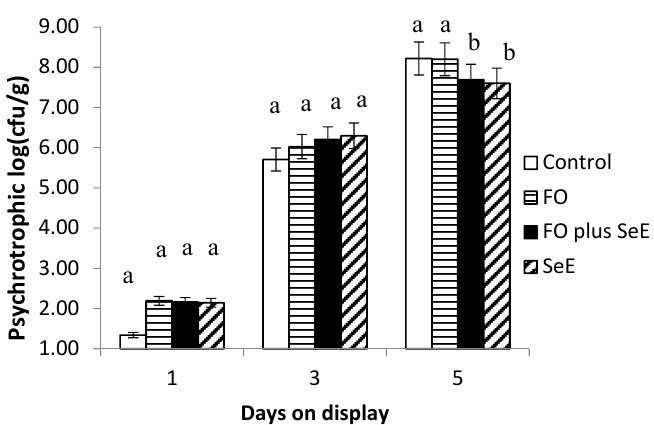
Figure 2. Mean log counts of psychrotrophic microorganisms obtained for the different treatments according to days on display; a, b—treatments in the same time point, followed by different lowercase letters, differ significantly at the 5% level.